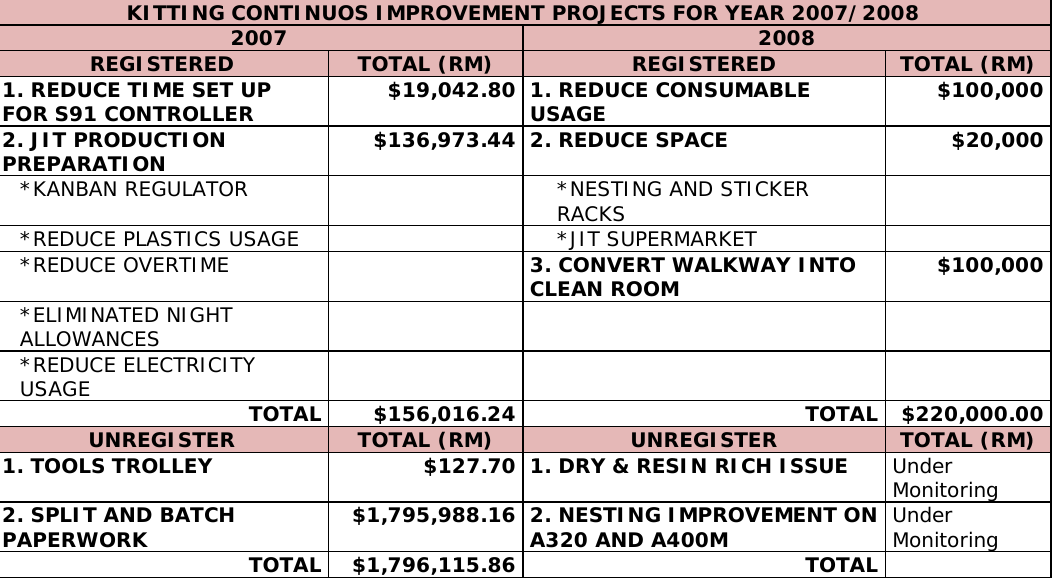
Table 2. “Continuous improvement projects for the year 2007 and